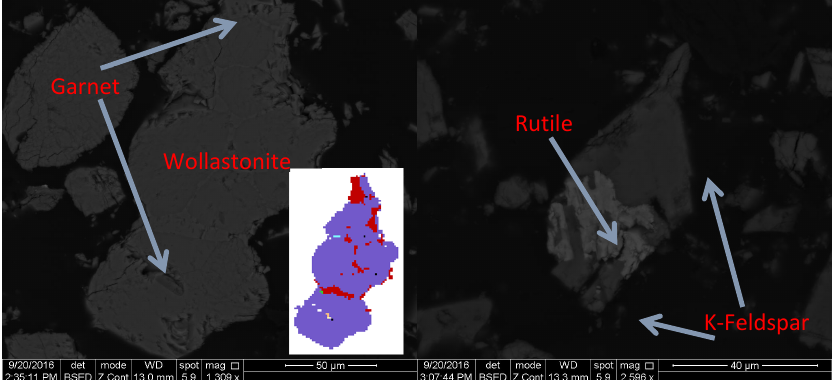
Figure 1. BSE images of wollastonite-calcite and feldspar samples. Table 1. Chemical analyses of the representative samples.